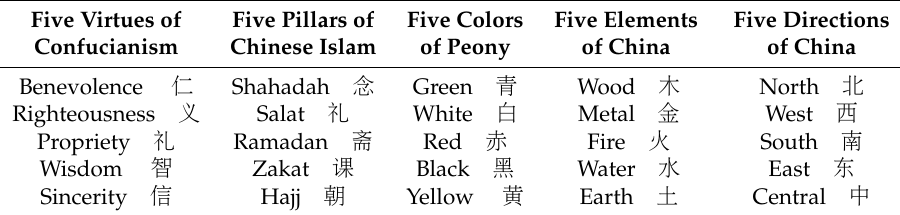
Table 2. Peony Metaphors and the Chinese-Islamic